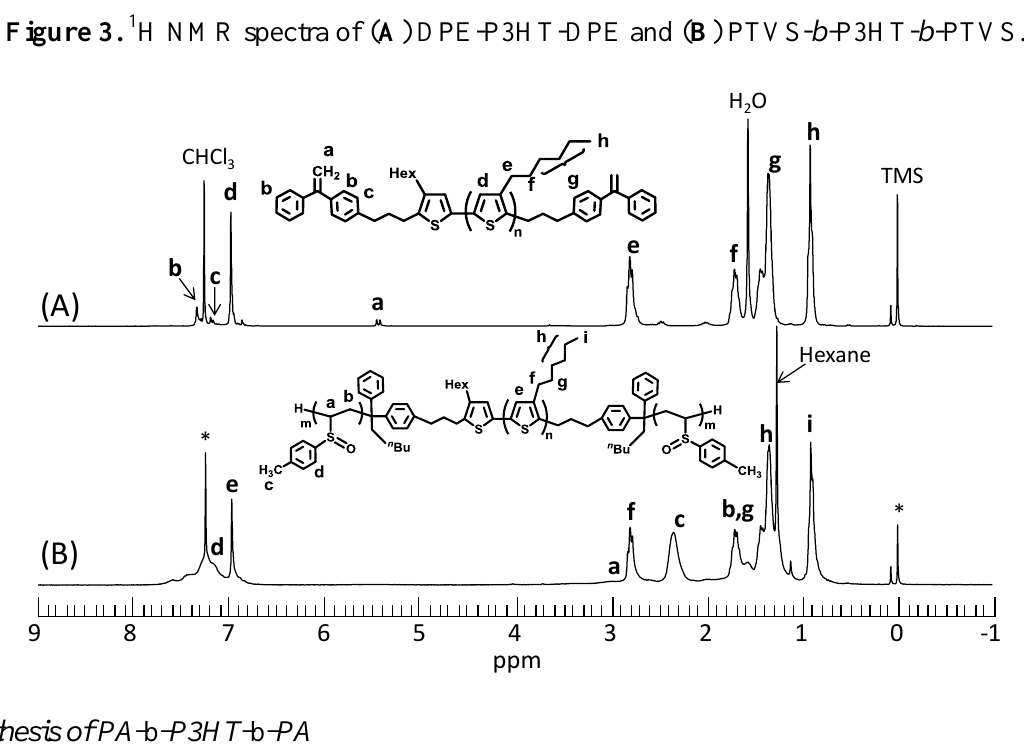
Figure 3. 1 H NMR spectra of ( A ) DPE-P3HT-DPE and ( B ) PTVS- b -P3HT- b